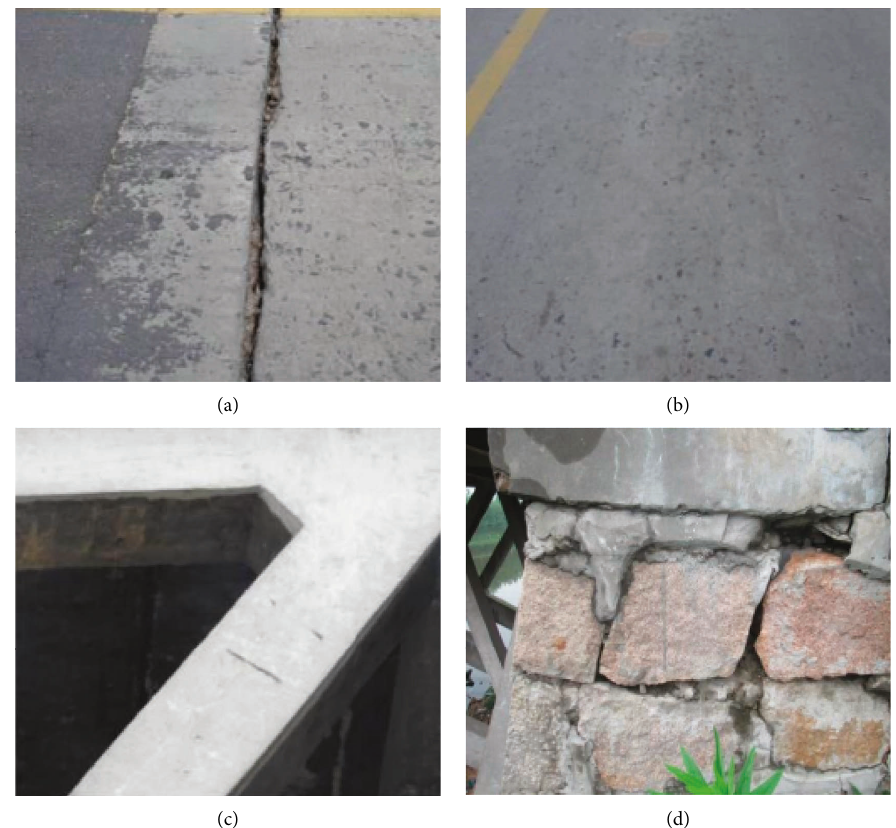
Figure 5: Different parts of the bridge damage. (a) Breakage expansion joint. (b) Bridge surface fracture. (c) Exposed reinforcing bar of truss beam. (d) Abutment